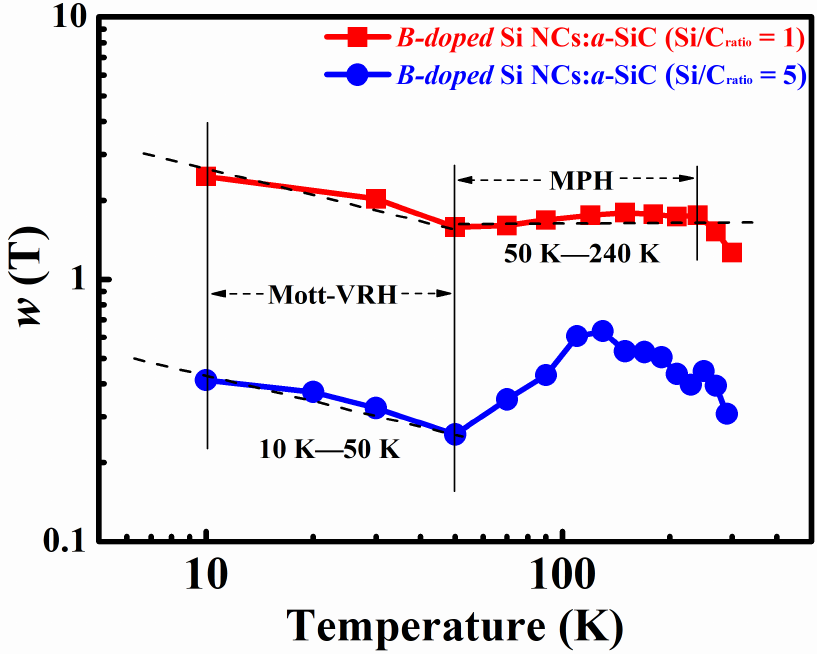
Figure 5. Temperature-dependent conductivities of B-doped Si NCs: a -SiC films with R = 1 and 5 below room temperature (10 K~300